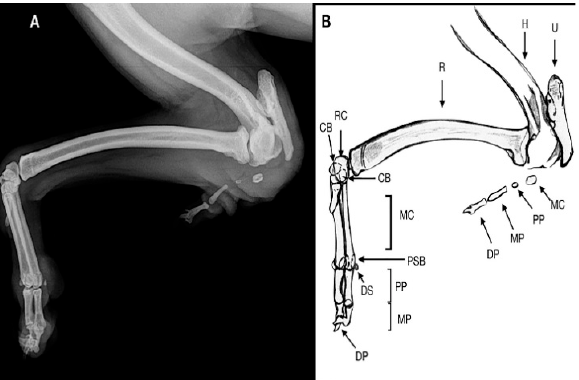
Figure 3. Case 1. Mediolateral radiograph ( A ) and drawing scheme ( B ) of the right forelimb mal-